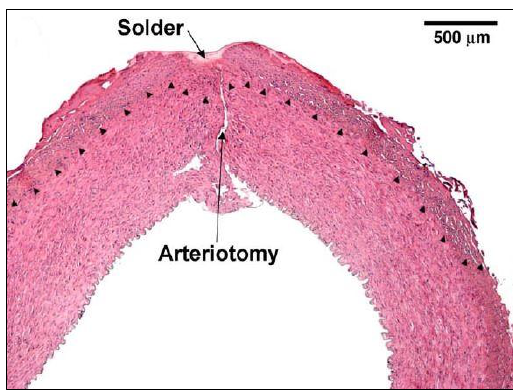
Figure 5. Transverse cross-section of an artery repaired by laser welding, with the application of a semi-solid solder solution